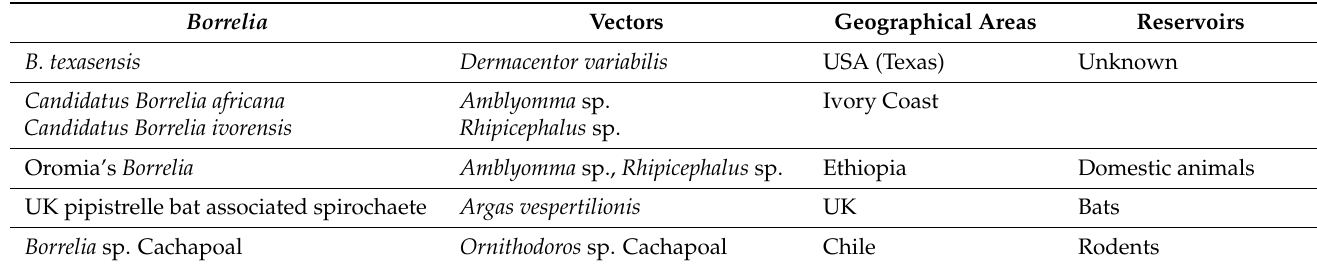
Table 6. Unclassified Borreliae